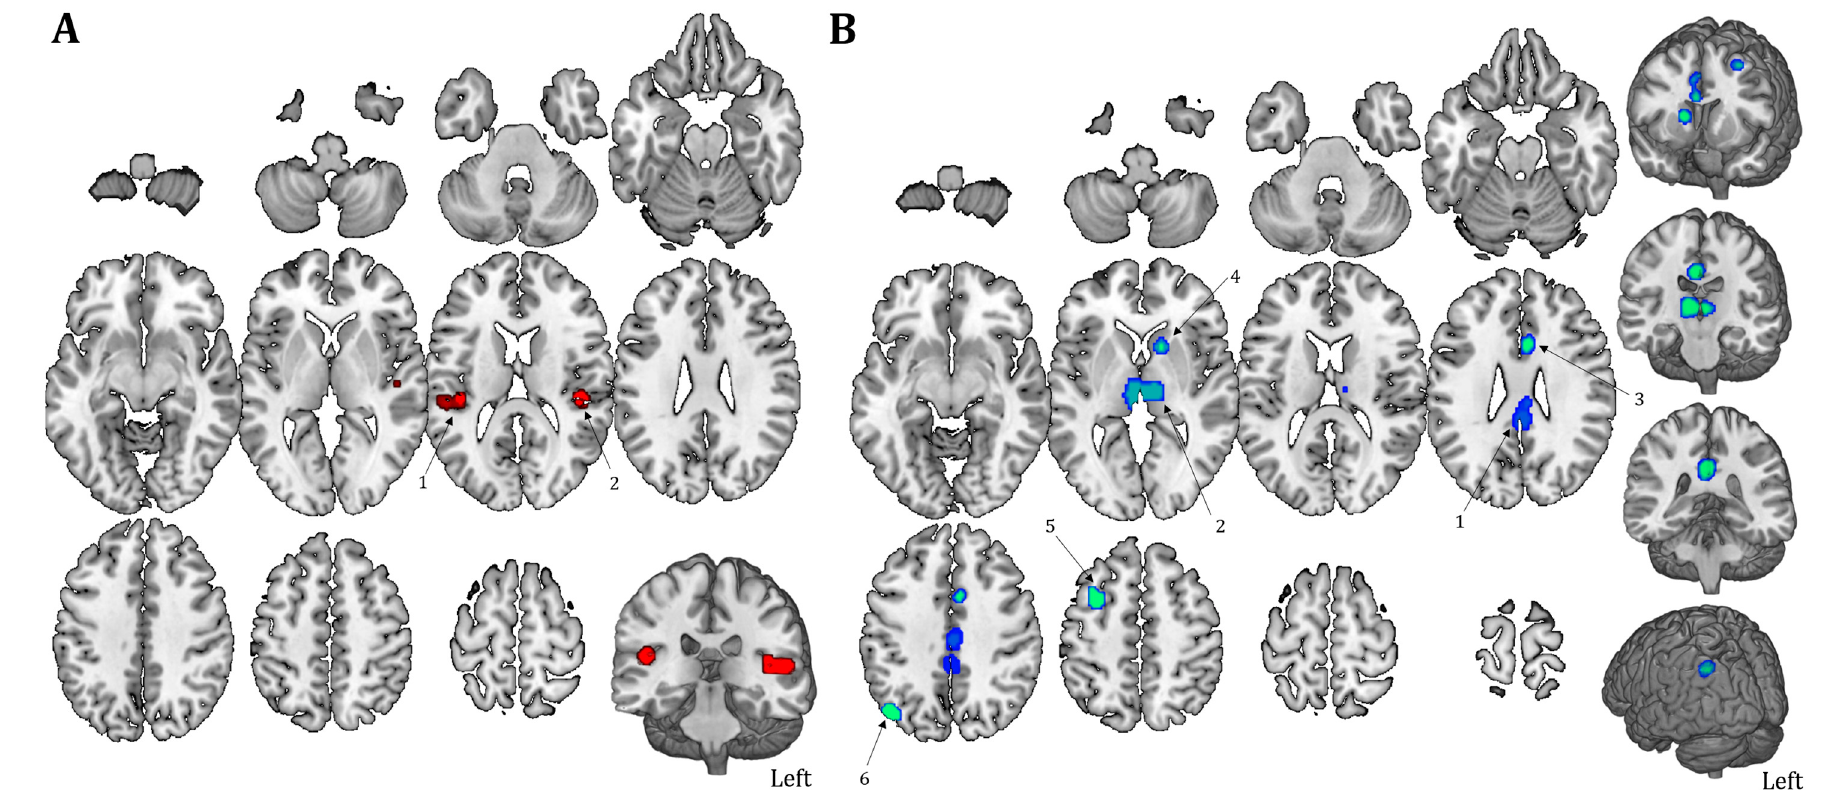
Figure 2. Task- and resting state-related activation map. ( A ) Temporal lobes are strongly activated when DoC patients performed a task (in red). ( B ) Brain hypoactivation in both internal and external awareness networks in patients compared to healthy controls during rs-fMRI (resting-state functional magnetic resonance imaging) is shown (blue). The ALE region numbers are reported.